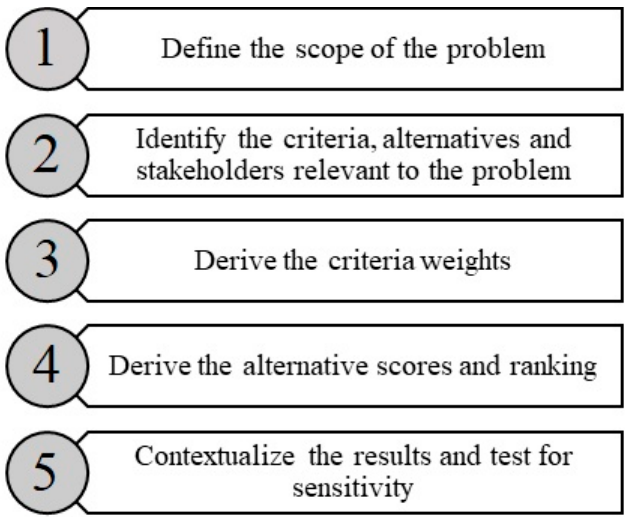
Figure 1. Stages of an MCDA analysis.